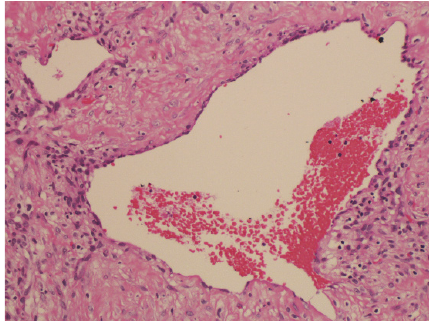
Figure 4: Richly vascular lesion which has variable-sized thin- walled vessels surrounded by a fibroblastic stroma. The vessels have asingleendothelialcellliningwithoutamuscularislayer(H&E20x).